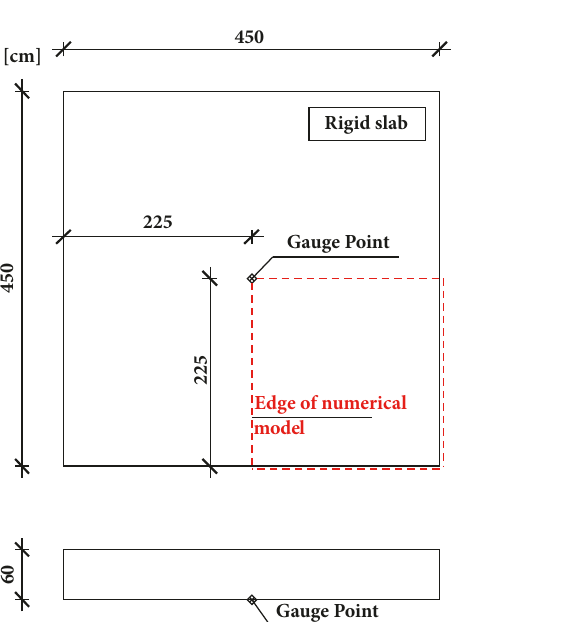
Figure 3: 3D explosion